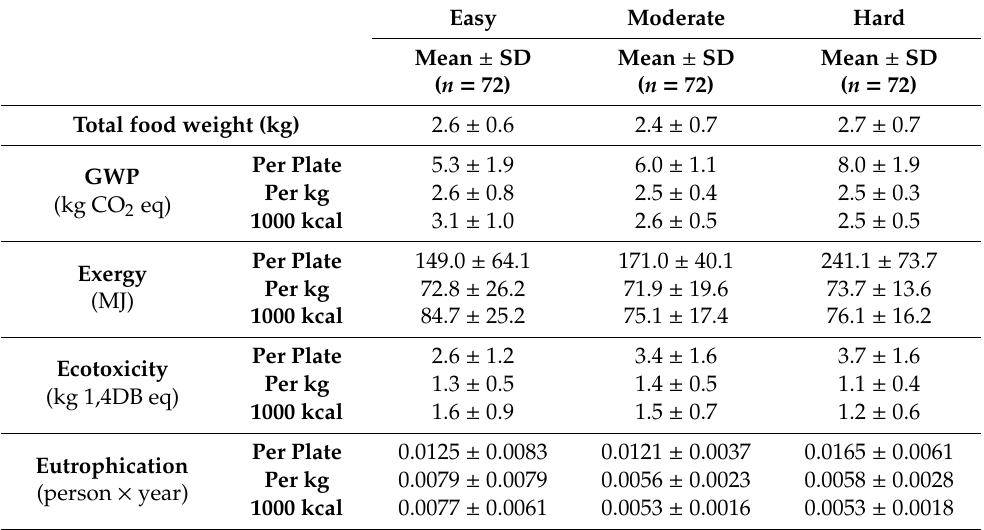
Table 2. Athlete’s Plate daily totals (sum of breakfast (B), lunch (L), and dinner (D)) by training